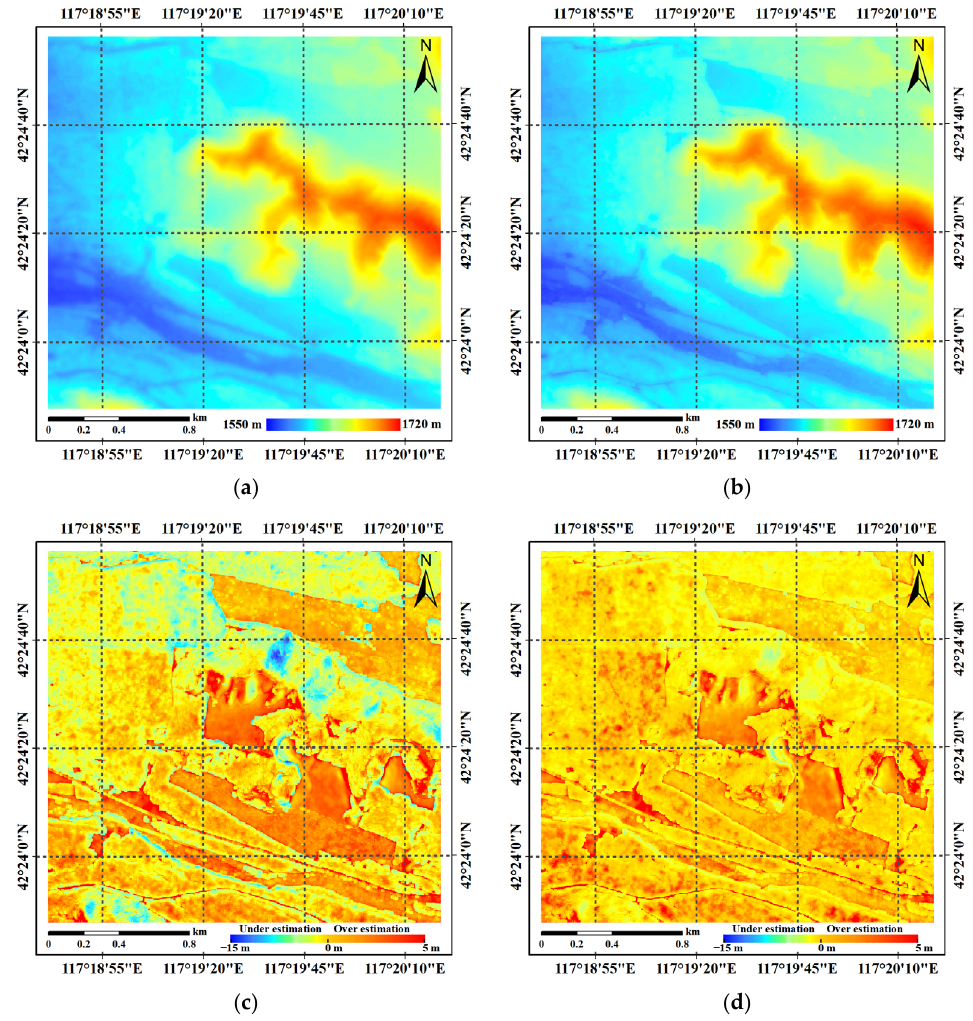
Figure 13. The compensated DSM and deviation of different methods: ( a ) The compensated DSM based on IDUV; ( b ) The compensated DSM based on the MLM; ( c ) Difference between DSM X-IDUV and DSM LiDAR ; ( d ) Difference between DSM X-MLM and DSM LiDAR .